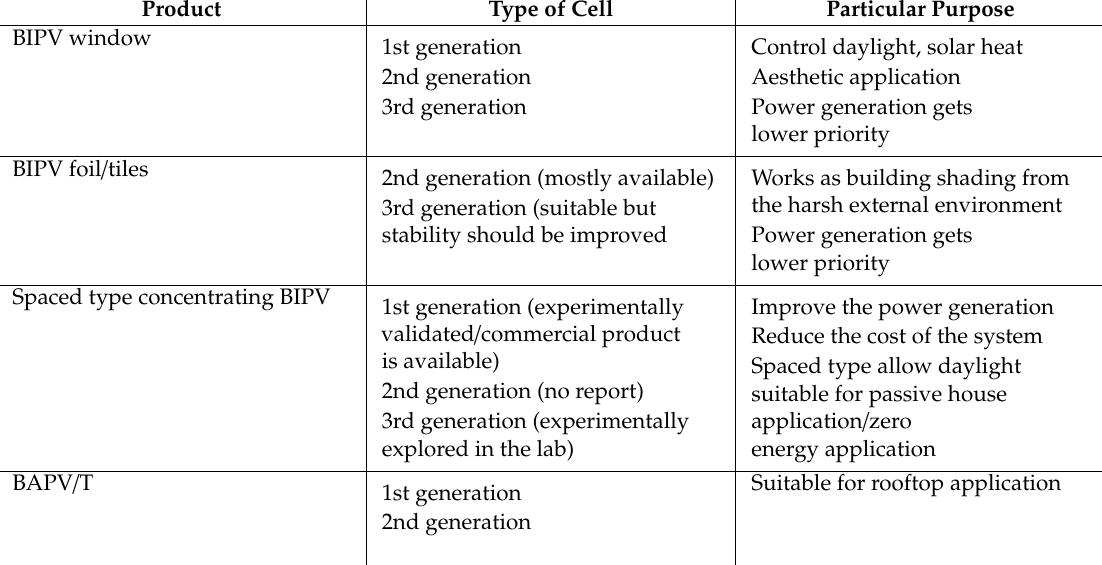
Figure 5. BAPV/T system installed at Sodha BERS complex, Varanasi (25.33° N, 82.99° E)[134]. Figure 5. BAPV / T system installed at Sodha BERS complex, Varanasi (25.33 ◦ N, 82.99 ◦ E) [134]. Table 2. Details of di ff erent BIPV and BAPV Table 2. Details of different BIPV and BAPV products.